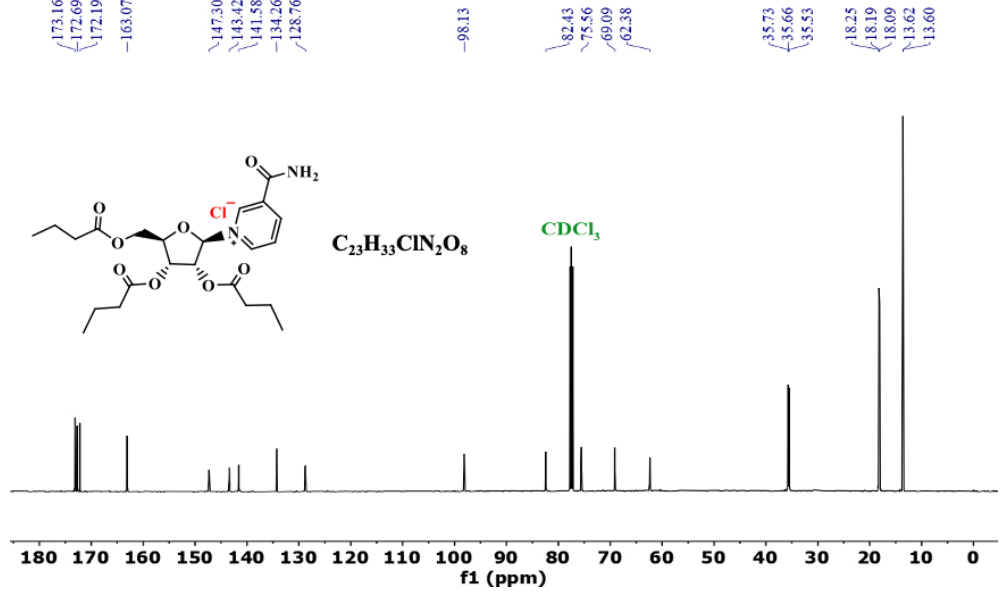
Figure 5. 13 C NMR of NRTBCl in CDCl 3.